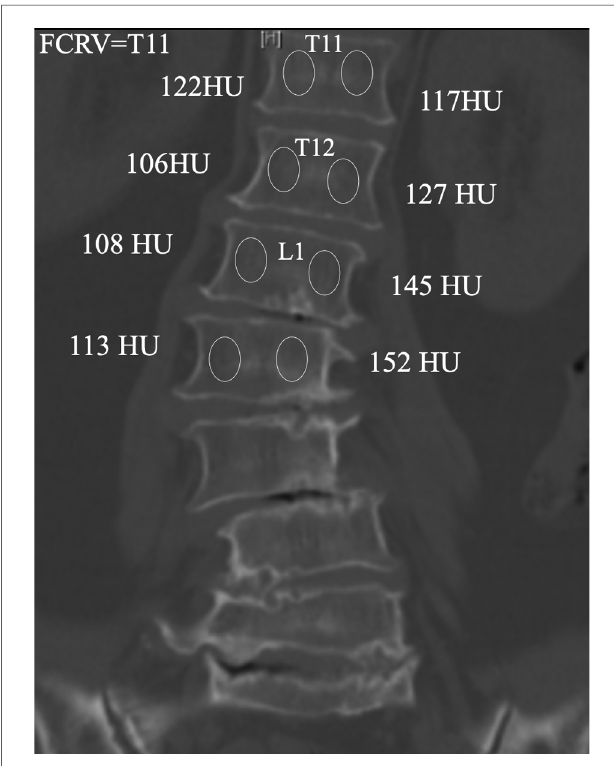
FIGURE 2 Schematic diagram of FCRV measurement, which is de fi ned as the fi rst vertebrae that presents opposite orientation of asymmetric houns fi eld unit (HU) ratio from the other vertebrae within major curve.